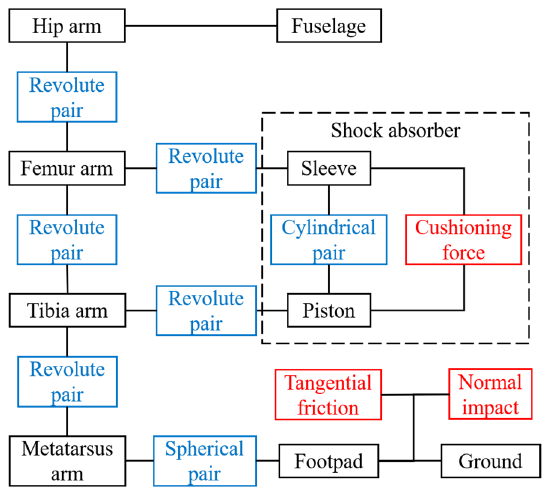
Figure 4. The framework of motion pairs in the dynamic model of the adaptive landing gear.